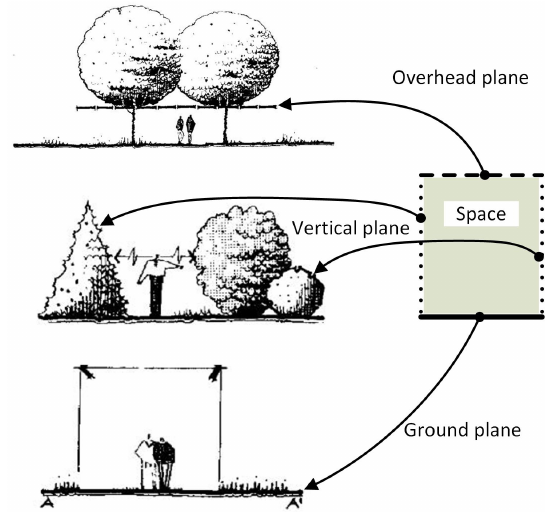
Figure 10. Example of geometric modelling of space in the landscape. Adapted from the figures in Reference